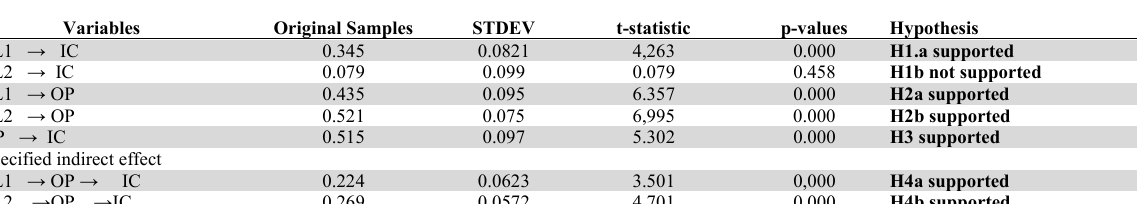
Structural Model